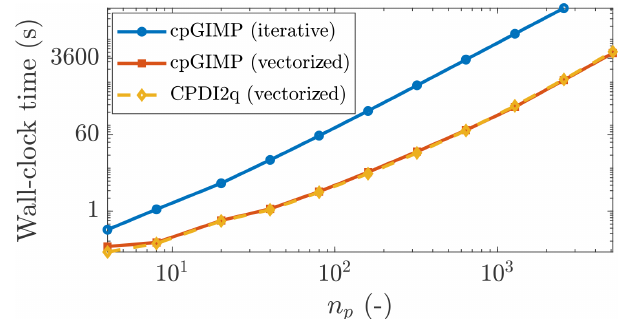
Figure 10. The wall-clock time for cpGIMPM (vectorized and it- erative solutions) and the CPDI2q solution with respect to the total number of material points n p . There is no significant differences between the CPDI2q and cpGIMPM variants regarding the wall- clock time. The iterative implementation is also much slower than the vectorized implementation.